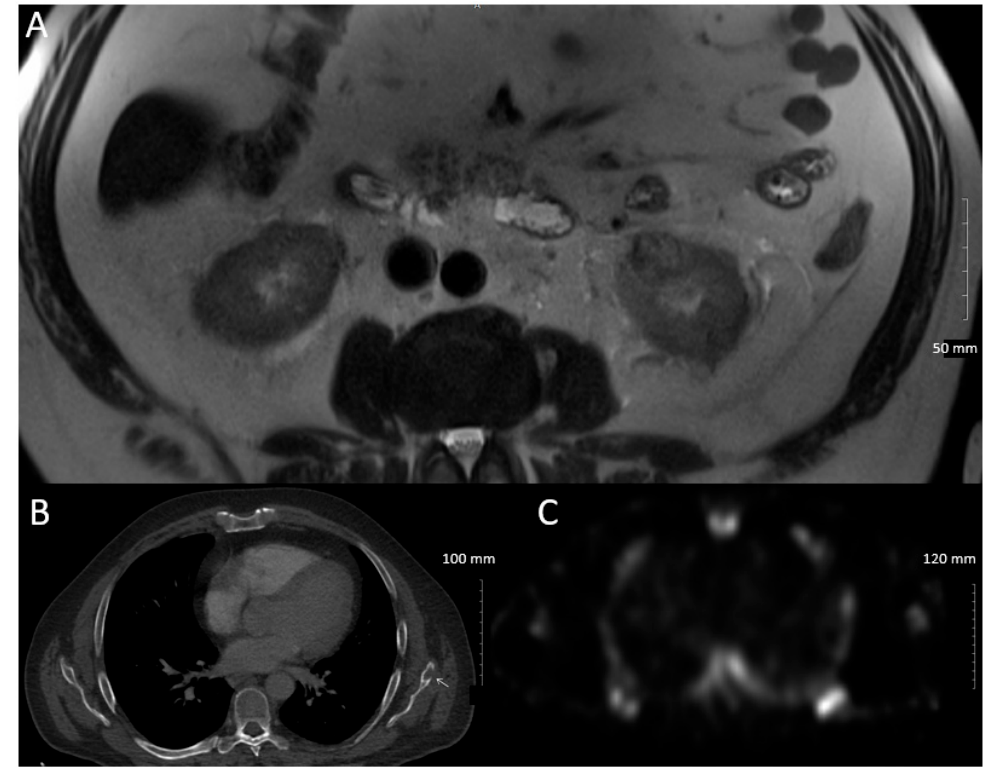
Figure 4. ( A ) Axial echo planar fast spin echo MR images showing stability of the left renal lesion that is heterogeneously T2 iso- and hypointense; ( B ) Bone scan showing stability of abnormal focal radiotracer uptake in the inferior tip of the left scapular body; ( C ) CT showing stability of lesion in the left scapula.